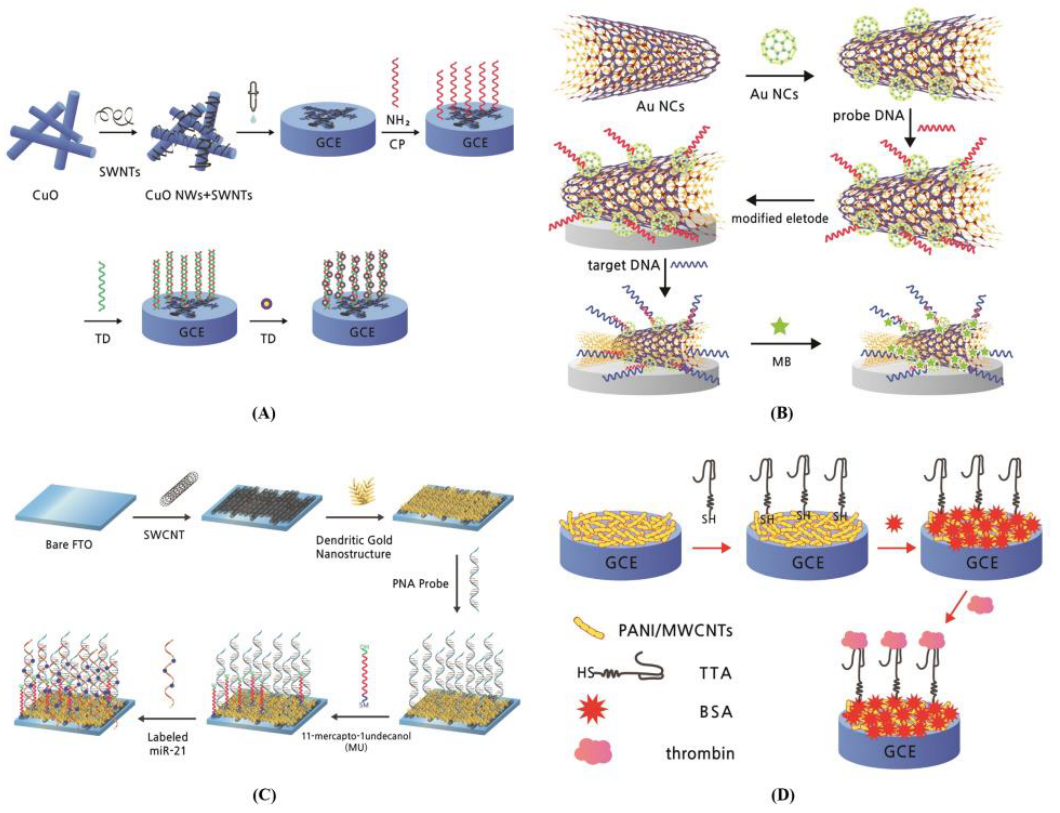
Figure 7. CNT-based biosensor with deoxyribonucleic acid (DNA) enzyme as a bioreceptor